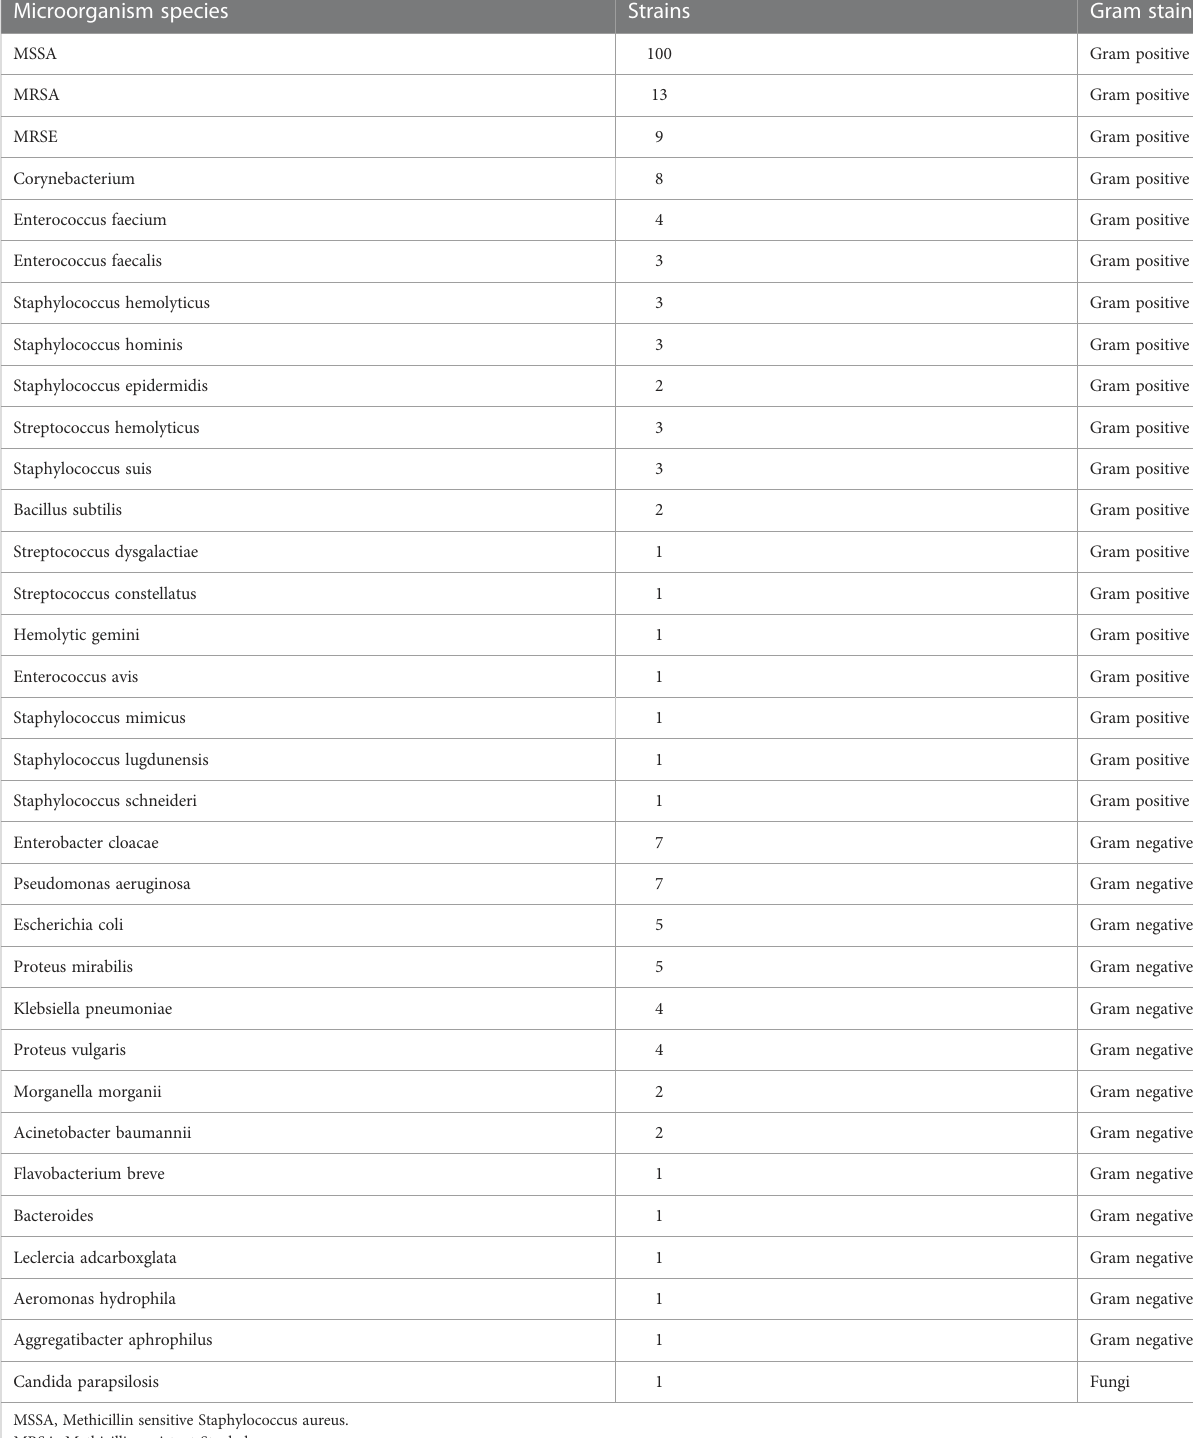
TABLE 3 Microorganism species and quantities. Microorganism